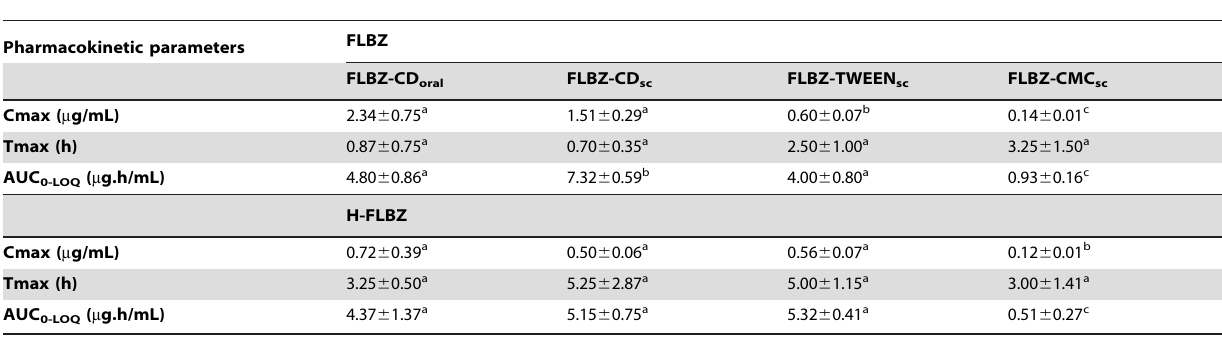
Table 1. Pharmacokinetic parameters (mean 6 SD) obtained for flubendazole (FLBZ) and its hydrolyzed metabolite (H-FLBZ) after treatment (5 mg/kg) with different FLBZ formulations to uninfected rats: Cyclodextrin-based (FLBZ-CD oral or FLBZ-CD sc ), Tween- based (FLBZ-TWEEN) and carboxy methylcellulose-based